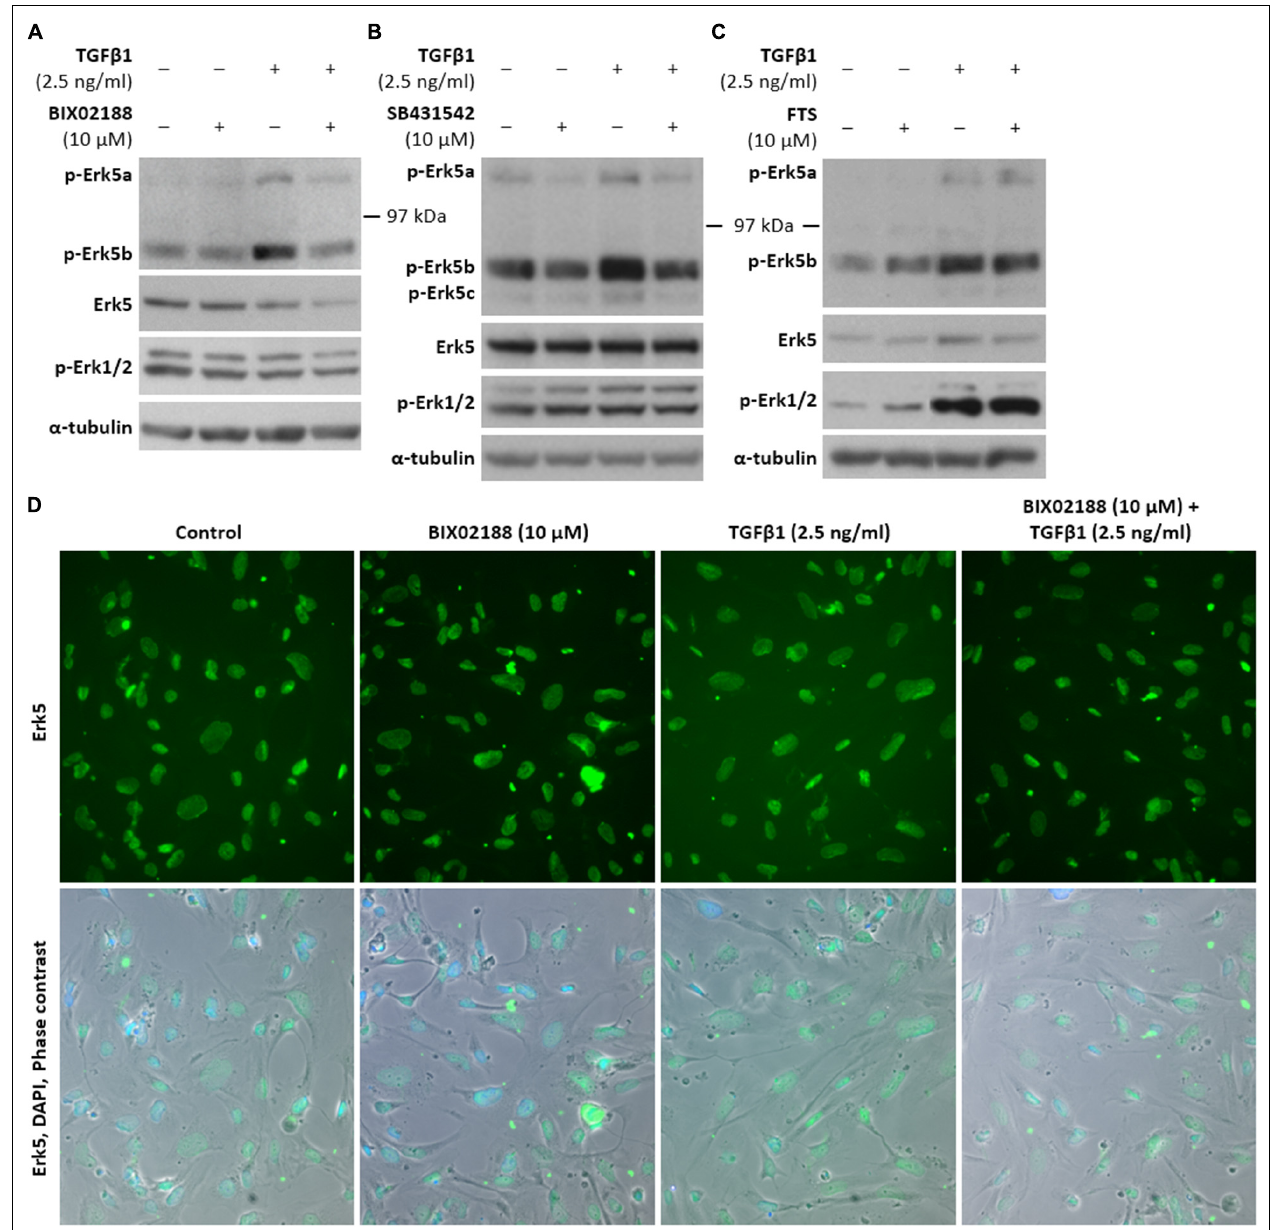
FIGURE 1 | Erk5 expression, activation, and subcellular localisation in podocytes viaTGF β 1. (A) Representative western blot of p-Erk5, Erk5, and p-Erk1/2 protein expression in conditionally immortalized human podocytes pre-incubated for 60 min with the Mek5 inhibitor BIX02188 (10 μ M) followed by co-incubation with TGF β 1 (2.5 ng/ml) for 5 min. Podocytes expressed Erk5 protein and TGF β 1 significantly increased protein levels of p-Erk5b ( P < 0.05), whilst BIX02188 co-treatment reduced Erk5 activation in response to TGF β 1 ( P < 0.05); Erk5 was used as a loading control; paired t -test, n = 3. Levels of p-Erk1/2 did not significantly decrease with BIX02188 co-treatment relative to the TGF β 1 stimulus; α -/ β -tubulin was used as a loading control; one-way ANOVA with Tukey’s multiple comparison post hoc test, n = 3. (B) Representative western blot of p-Erk5, Erk5, and p-Erk1/2 protein expression in podocytes pre-incubated for 30 min with the Alk5 inhibitor SB431542 (10 μ M) followed by co-incubation with TGF β 1